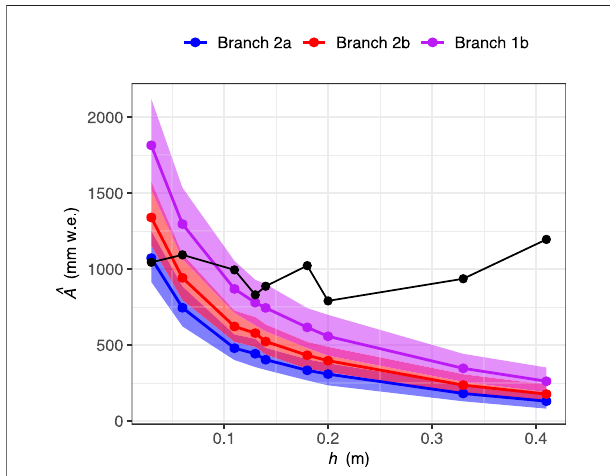
FIGURE 7 | Predicted (blue, branch 2a, red, branch 2b, and purple, branch 1b) and observed (black) sub-debris glacier ice ablation for the 2016 hydrologicalyear,plottedagainstdebristhickness.Thecolouredsymbolsand lines represent the median values, and the coloured ribbons represent uncertainty bounds based on the 10th and 90th percentiles around the medians.